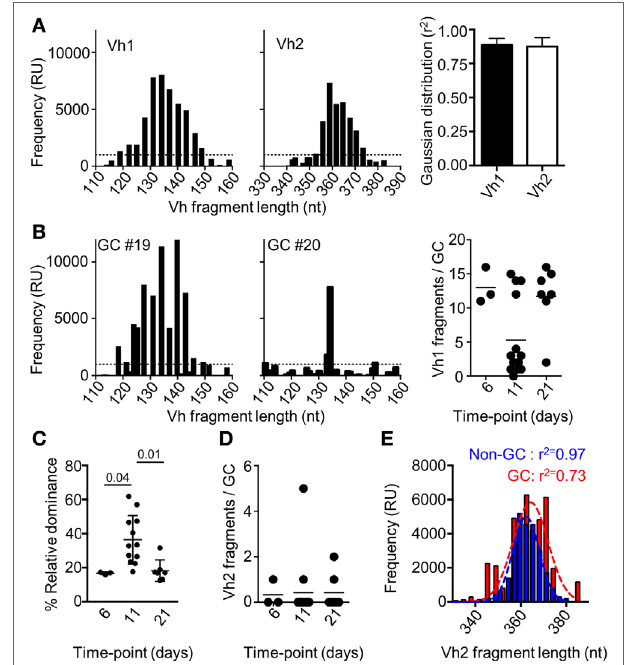
FigUre 2 | Fragment analysis for the presence of B cell clones of the Vh1 or Vh2 families. (a) Splenocytes from uninjected mice ( N = 3) were assessed for the number of Vh1 (left panel) or Vh2 (mid panel) fragments of different nucleotide length that could be amplified. The distribution of the fragments with respect to their frequency was assessed for adherence to a Gaussian distribution (right panel). (B) Fragment analysis of the Vh1 family in single germinal centers (GCs) after isolation by laser capture microdissection. Shown are representative histograms of the Vh1 distribution in polyclonal GCs (left panel) and relatively monoclonal GCs (mid panel), 11 days after injection with Env. Enumeration of how many distinct Vh1 fragments that could be found in each of the isolated single GCs on day 6 ( N = 3), day 11 ( N = 14), and day 21 ( N = 7) was performed (right panel). (c) The relative dominance of the VDJ fragment with the highest frequency among all detected Vh1-family VDJ fragments is shown. (D) Shown is an enumeration of how many distinct Vh2 fragments that could be found in each of the isolated single GCs at different time-points. (e) GC B cells (B220 + IgD − GL7 + CD95 + , red) and non-GC B (B220 + IgD − GL7 − CD95 − , blue) cells were sorted and assessed for the frequency and number of amplified Vh2-family VDJ fragments. The r 2 -value indicates the adherence to a Gaussian distribution of different fragments with respect to their relative frequency.